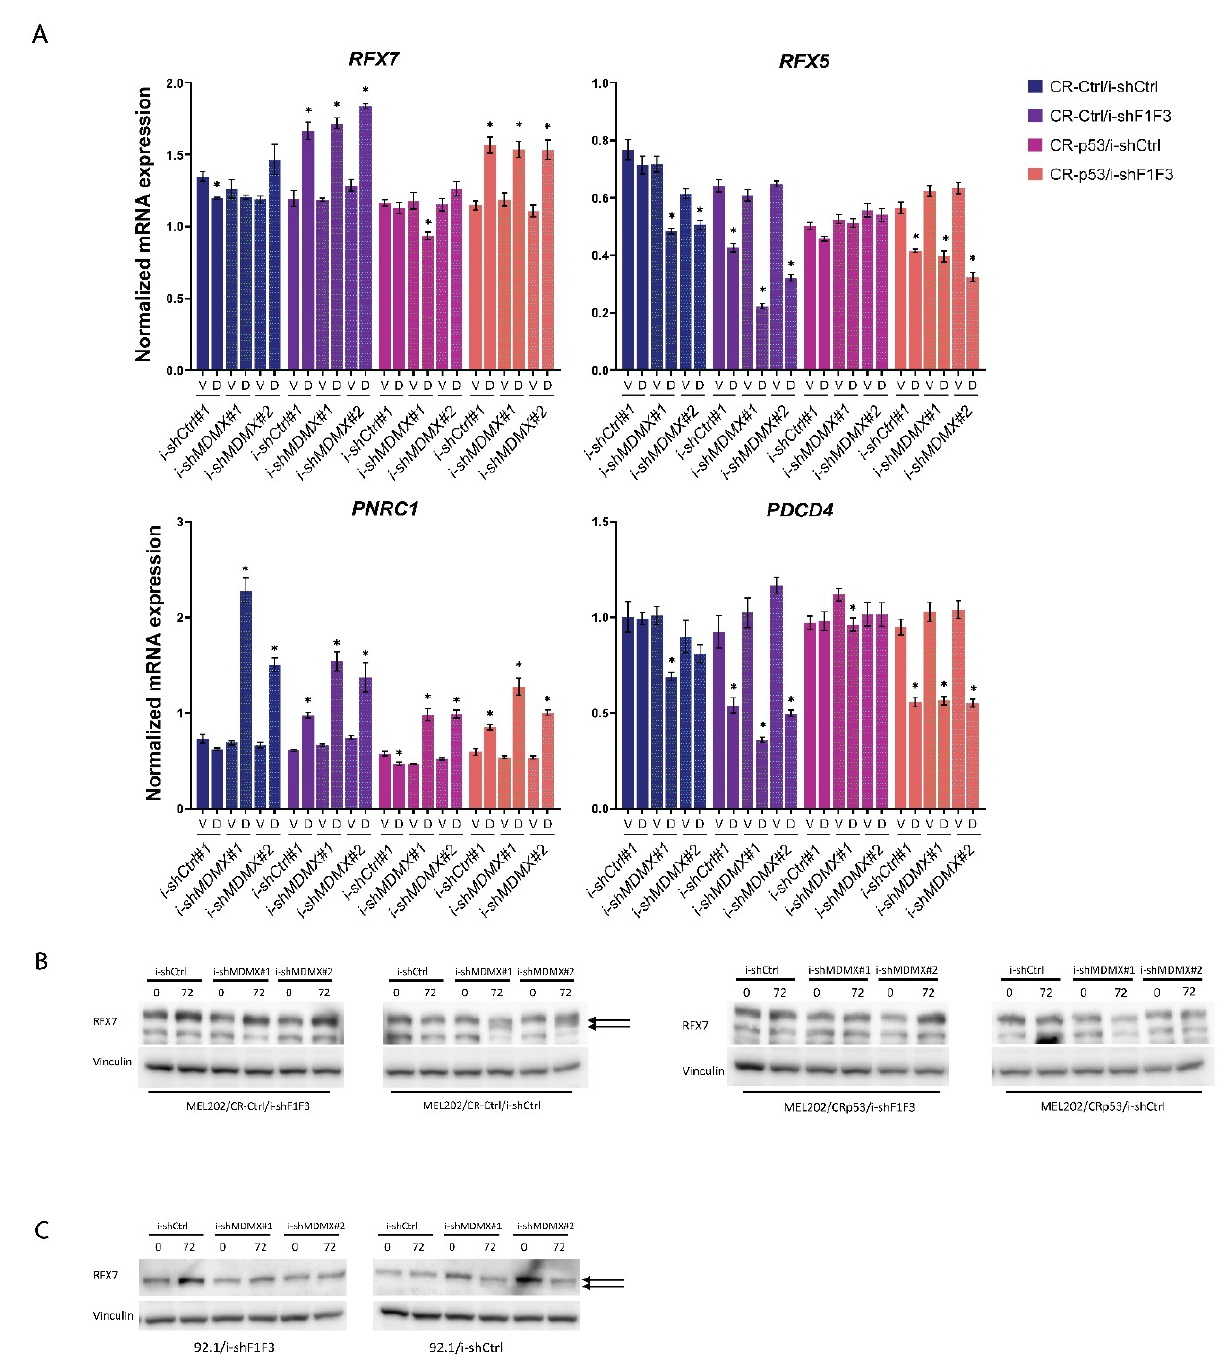
Figure 5. Analyses of RFX7 involvement in transcriptional regulation of genes upregulated upon MDMX depletion. ( A , B ) MEL202/CR-Ctrl and/CR-p53, i-shCtrl and i-shF1F3, containing either i-shCtrl or i-shMDMX shRNAs, were treated for 72 h with 10 ng/mL doxycycline (D) or Vehicle (V) after which RNA and protein was harvested and analyzed for the mRNA expression of RFX7 and the reported RFX7-target genes RFX5, PNRC1 and PDCD4 ( A ) and to evaluate the effect of MDMX depletion on RFX7 protein migration. Significant alterations ( p < 0.05) in gene expression are indicated with *. These are the same samples as analyzed in Figure 3. ( C ) 92.1/i-shCtrl and 92.1/i-shF1F3, i-shCtrl and i-shMDMX cell lines were treated for 72 h with 10 ng/mL doxycycline, after which protein lysates were harvested and analyzed for RFX7 expression. These are the same samples as analyzed in Supplementary Figure S6. Original blots see Supplementary File S1.